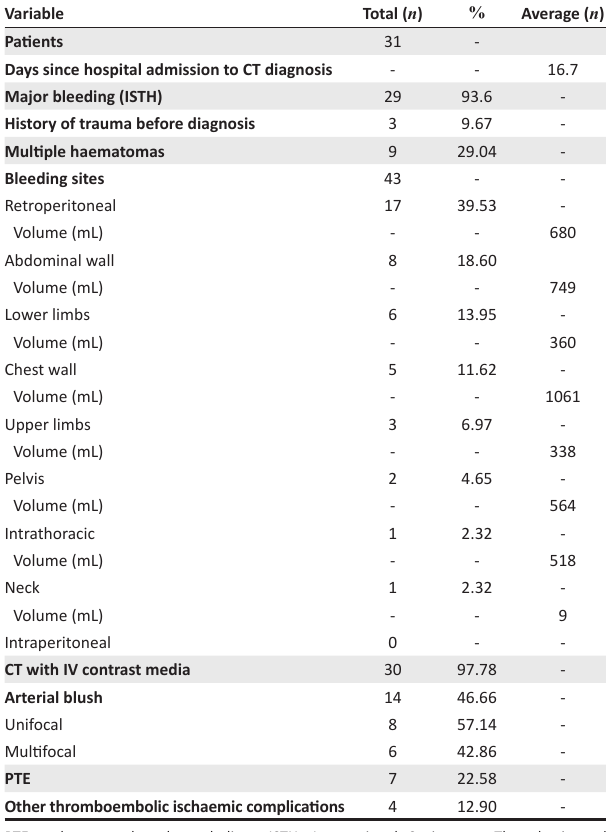
presence of bleeding in the retroperitoneal space ( p = 0.019; r = 0.42) and in the pelvis ( p = 0.022; r = 0.41) and the development of multiple haematomas.